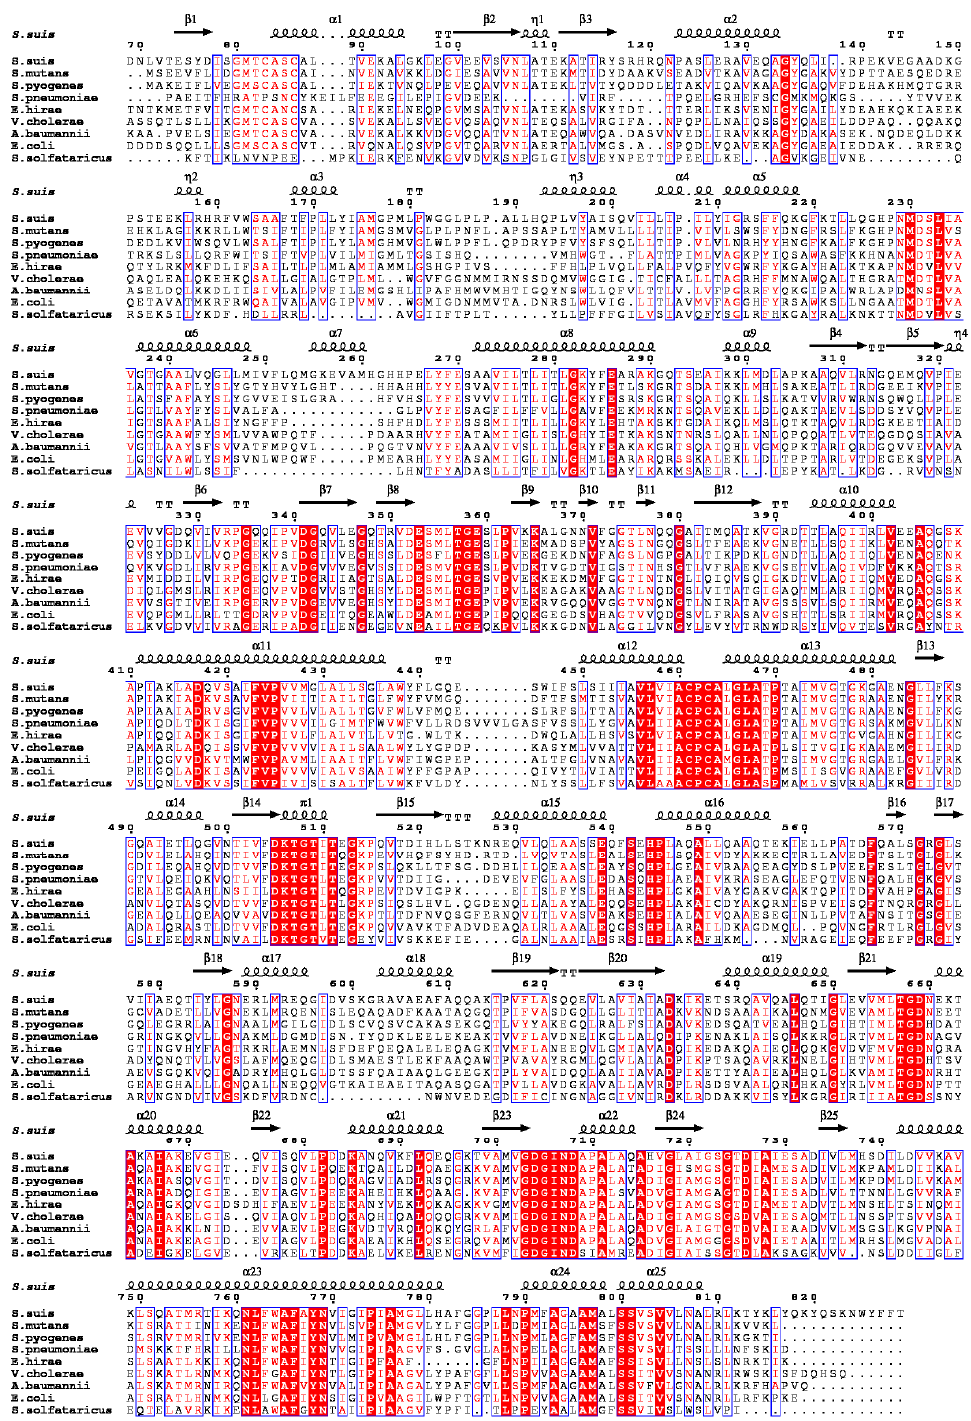
Figure 2. Multiple sequence alignments of CopA homologues. Identical residues are in white letters with red background; similar residues are in red letters with white background. The modelled structure of Streptococcus suis CopA is shown on the top. α indicates α -helix; β indicates β -sheet; η indicates coil; and T indicates turn. The GenBank accession numbers are as follows: S. suis , WP_012775225.1; Streptococcus mutans , NP_720873.1; Streptococcus pyogenes , AAZ52023.1; Streptococcus pneumoniae , WP_000136284.1; E. hirae , WP_131773415.1; Vibrio cholerae , NP_231846.1; Acinetobacter baumannii , AKA32424.1; Escherichia coli , NP_415017.1; and Sulfolobus solfataricus ,